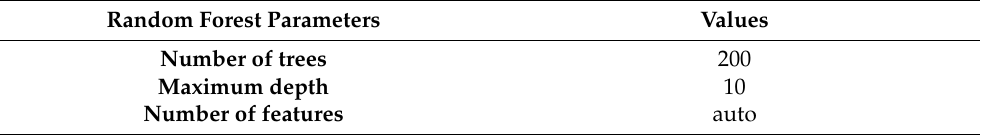
Table A3. Description of final optimized parameters for random forest ensemble learning.